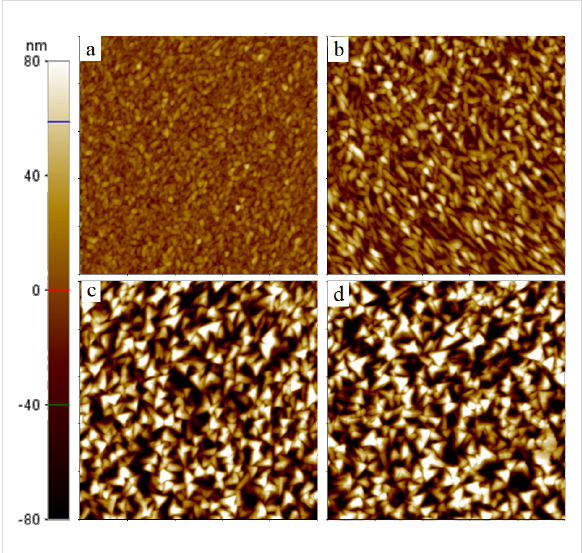
Figure 1: AFM images (5 × 5 μ m) of (a) c -20 (16.603 nm), (b) c -40 (26.756 nm), (c) c -60 (51.531 nm), and (d) c -70 (56.233 nm) ZnO@B samples. The surface roughness of each sample is given in the